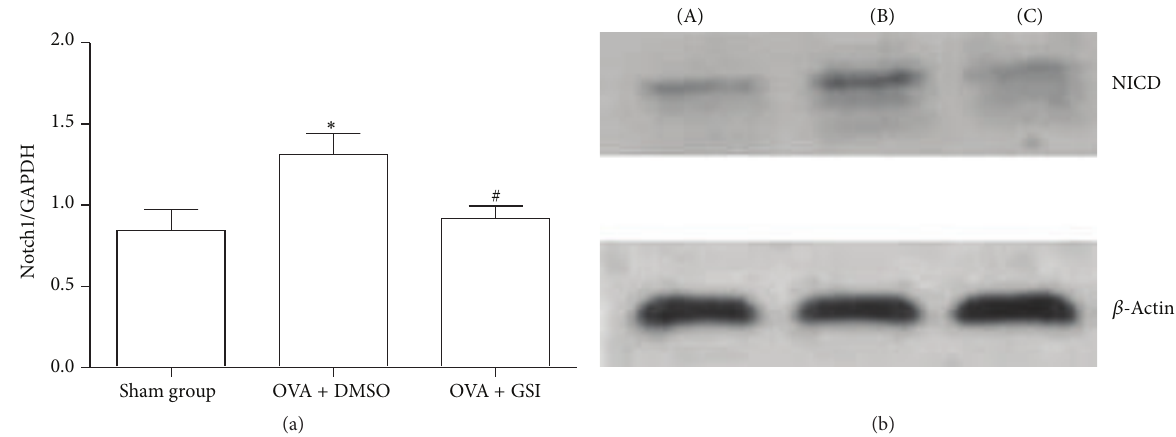
Figure 3: GSI decreased Notch1 and NICD. BALB/C mice were sensitized i.p. with OVA and challenged with OVA in the presence and absence of GSI. (a) The expression of Notch1 mRNA was evaluated by quantitative real-time RT-PCR. GAPDH was used as internal control. (b) Protein levels of NICD were examined by Western blotting. 𝛽 -actin was used as a loading control. (A) Sham group; (B) OVA + DMSO; (C) OVA + GSI. Data expressed as Mean ± SEM. 𝑁 = 8 mice per group. ∗ 𝑃 < 0.01 compared with the sham group. # 𝑃 < 0.01 compared with the vehicle